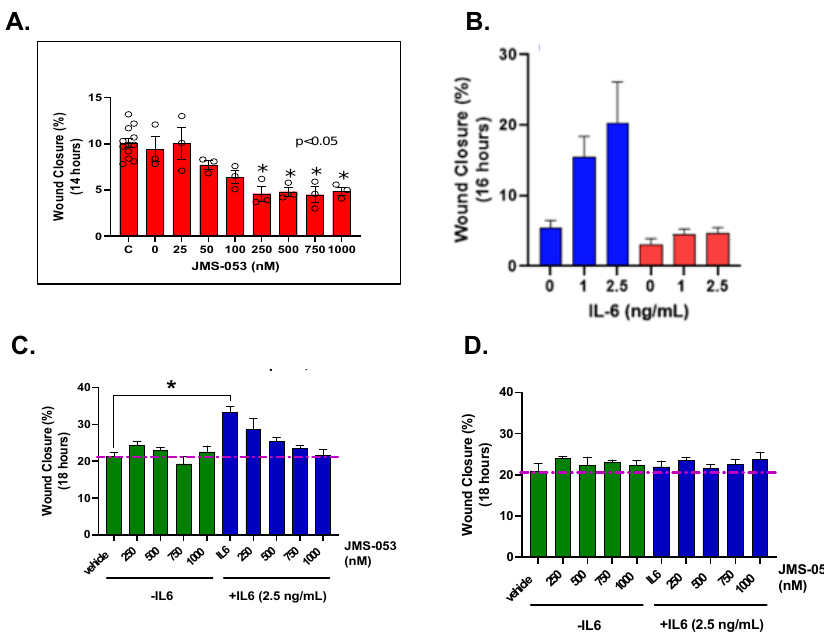
Figure 4. Inhibition of PTP4A3 activity blocks OvCa cell migration. ( A ) JMS-053 inhibits migration of A2780 cells. A2780 were cultured to confluence then “wounded” and treated with vehicle control or JMS-053. Wound closure was quantified at 14 h post-wounding. Mean ± SEM ( B ) IL-6 caused a concentration-dependent migration in PTP4A3 wildtype OVCAR4 cells (blue). CRISPR/Cas9 knock-out of PTP4A3 in OVCAR4 cells reduces IL-6 mediated cell migration (red). Mean ± SEM. ( C ) JMS-053 causes a concentration-dependent inhibition of IL-6-mediated migration in wildtype OVCAR4 cells. Wound closure was quantified at 18 h post-wounding. Mean ± SEM. N = 3.Vehicle control indicated by the red line. ( D ). With OVCAR4-PTP4A3 knockout cells, JMS-053 did not cause any further inhibition of migration in the presence of IL-6. Wound closure was quantified at 18 h post-wounding. Mean ± SEM, N = 3. * p < 0.05